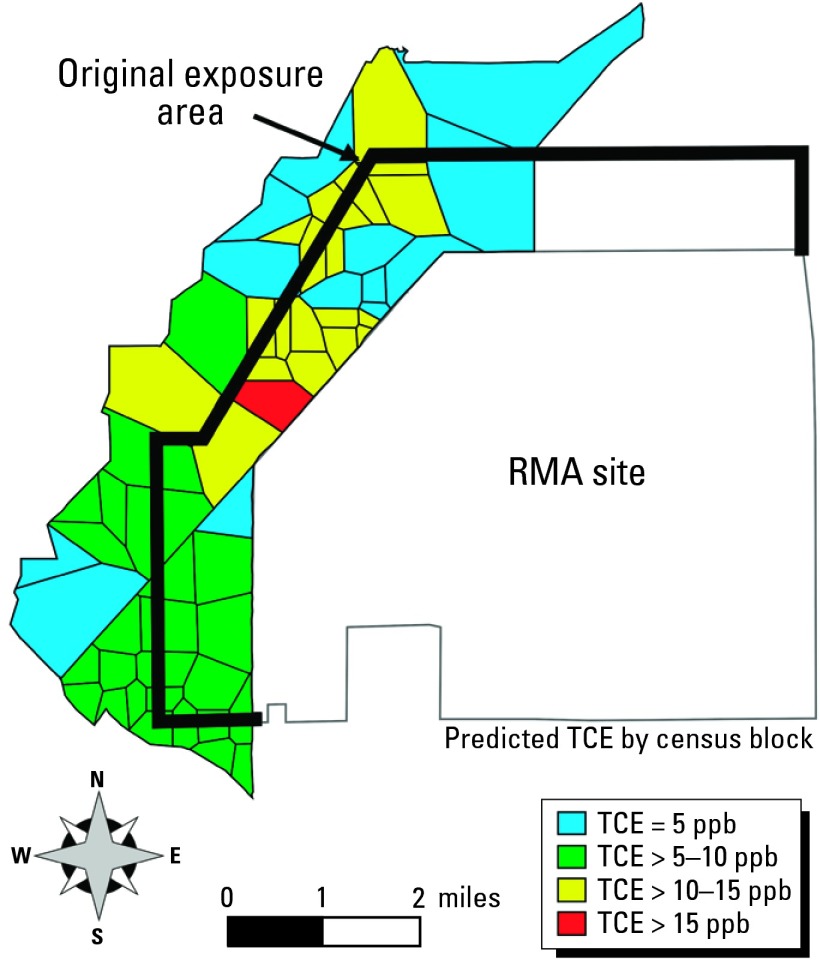
Exposure zone in original RMA study (ATSDR 1996) and refined resolution of predicted exposure to TCE by census block as reported by Reif et al. (2003).